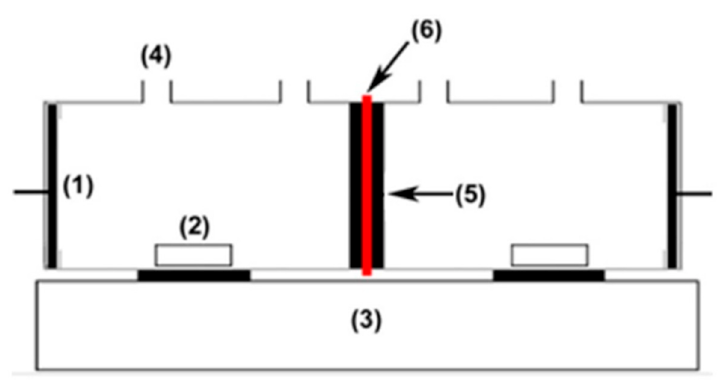
Figure 1. Schematic diagram of testing apparatus for membrane potential: (1) Pt electrode, (2) magnetic bar, (3) stirrer, (4) orifice, (5) rubber ring, (6) membrane.